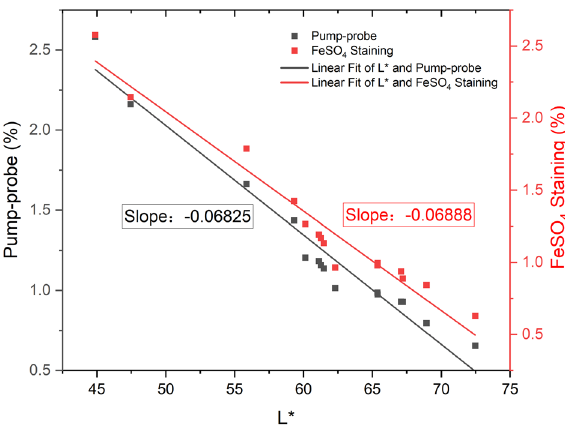
Figure 5. Correlation between the MCI and the L* value.